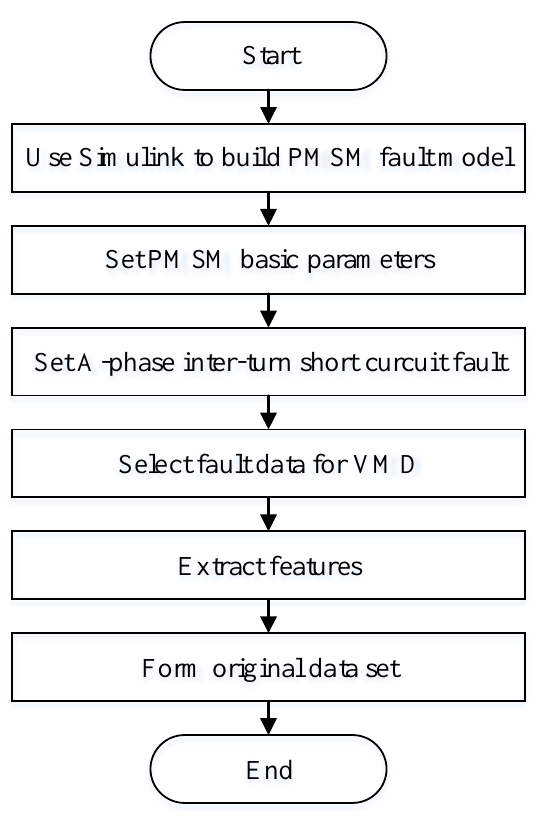
Figure 9. Building a Dataset